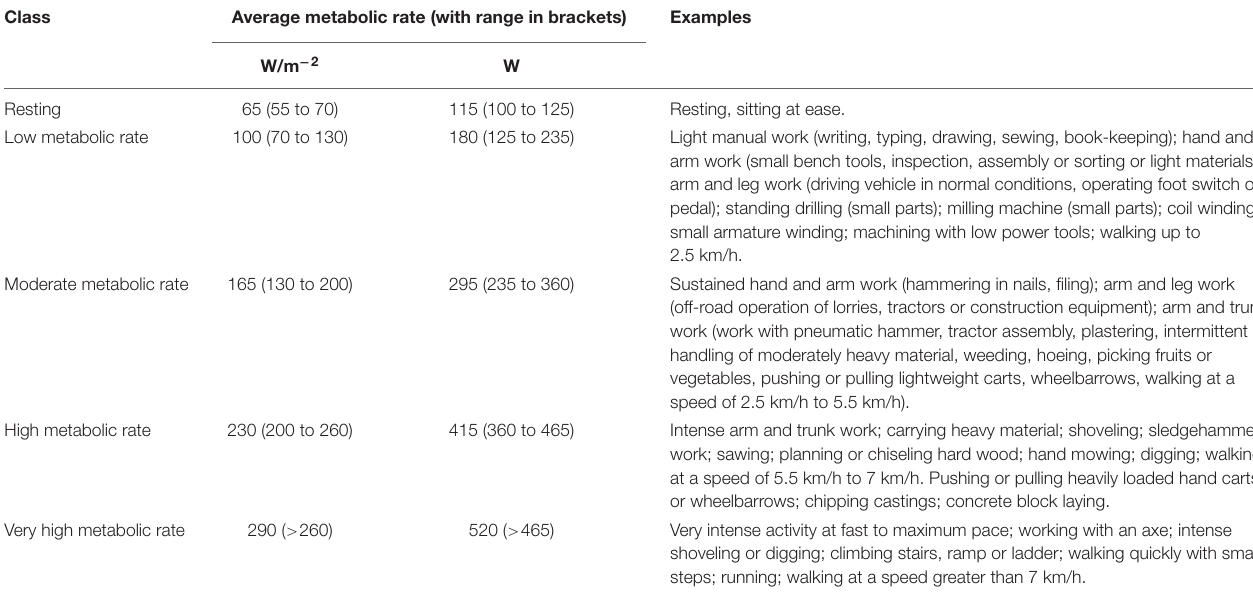
TABLE 1 | Classification of work intensity according to heat production and type of activity. Class Average metabolic rate (with range in brackets) Examples